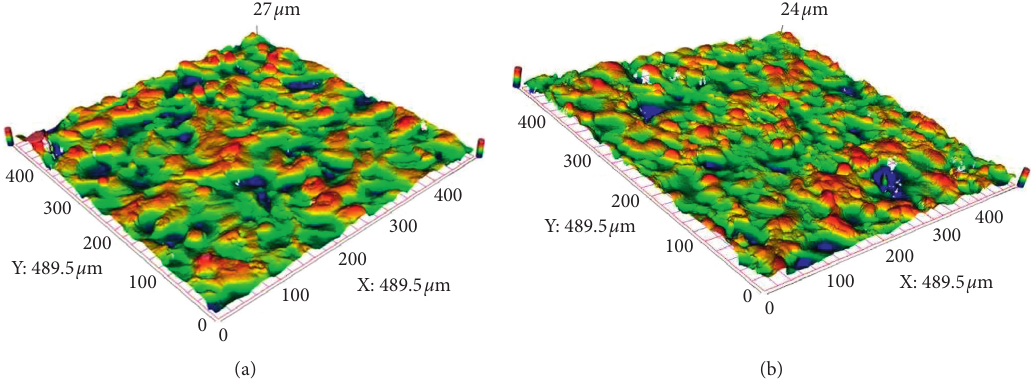
Figure 2: Surface topography of EDM continuous discharge: 3D view and crater shape and dimensions ( I